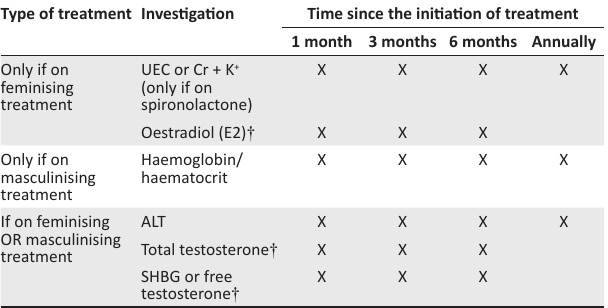
FIGURE 2: Suggested baseline screening prior to hormone therapy initiation. Baseline sex hormone levels are generally TABLE 6: Laboratory monitoring for feminising and masculinising therapy.